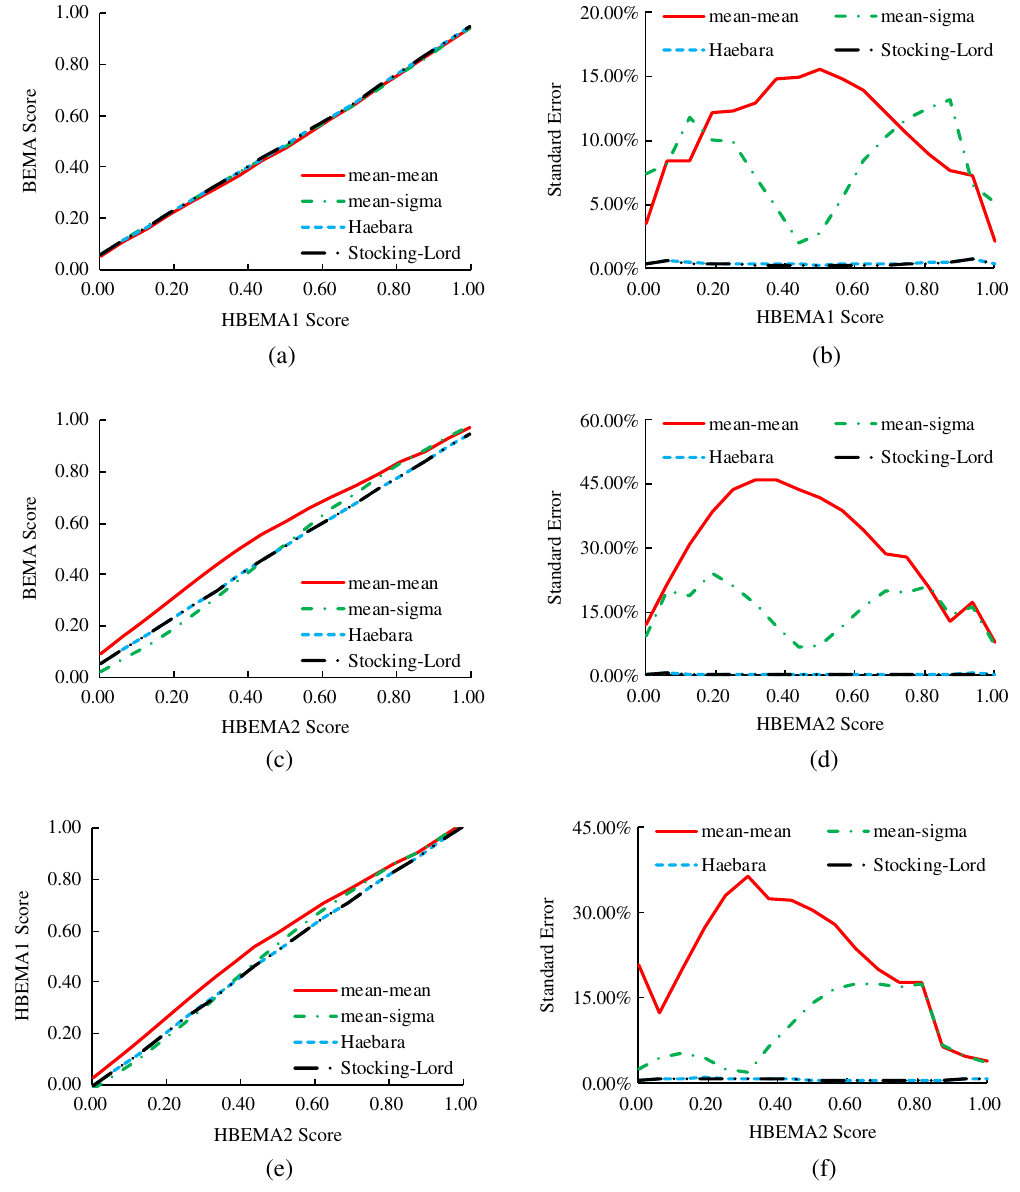
FIG. 2. Results for equating. (a) – (b) Equating function and SE for equating BEMA and HBEMA1; (b) – (c) Equating function and SE for equating BEMA and HBEMA2; (e) – (f) Equating function and SE for equating HBEMA1 and